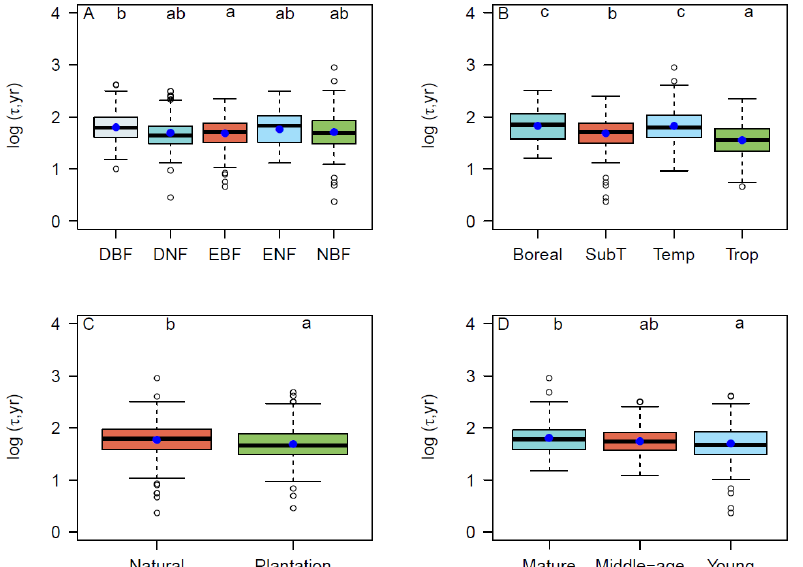
Figure 2. Subsoil τ boxplots for each forest type ( A ); climate zone ( B ); forest origin ( C ); and forest age ( D ). Lowercase letters (a, b, c) indicate significant differences ( p < 0.05). Blue points indicate the average. SubT—subtropical; Temp—temperate; Trop—tropical. Table 1. Two-way ANOVA of forest types, climatic zones, and their interaction effect on subsoil τ .